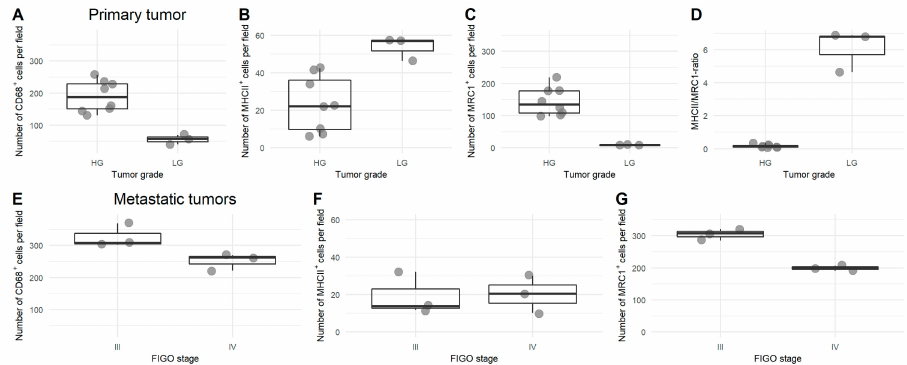
Figure2. Comparisonofmacrophageprofileinlow-gradeversushigh-gradetumorsandinInternational Federation of Gynecology and Obstetrics (FIGO) stage III versus IV. ( A – C ) Number of CD68 + ( A ), MHCII + ( B ), and MRC1 + ( C ) cells per field in primary high-grade and low-grade tumor samples. Ratio between MHCII + / MRC1 + (i.e., M1 / M2) in high-grade vs. low-grade ovarian cancer ( D ). ( E – G ) Number of CD68 + ( D ), MHCII + ( E ), and MRC1 + ( F ) cells per field in metastatic biopsies of stage III and stage IV ovarian